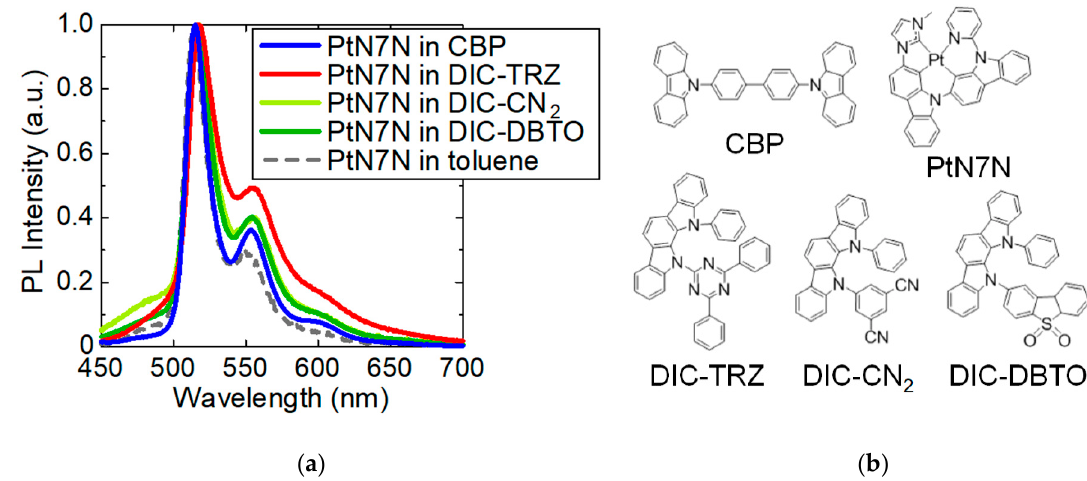
Figure 1. PL spectra and molecular structures of PtN7N in different host materials such as CBP, DIC–TRZ, and toluene (1 × 10 − 5 M): ( a ) the normalized PL spectra and ( b ) the molecular structures.